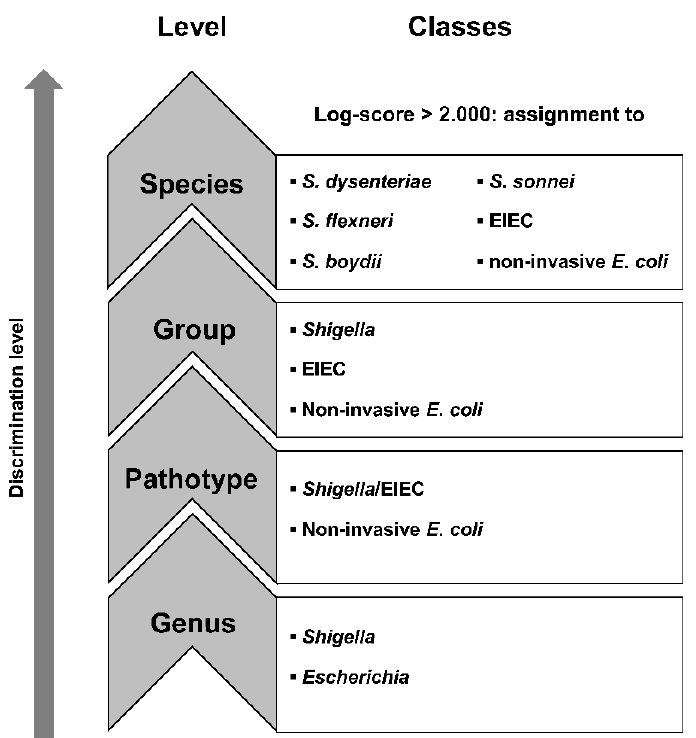
Figure 1. The classes in the different discrimination levels to which isolates were